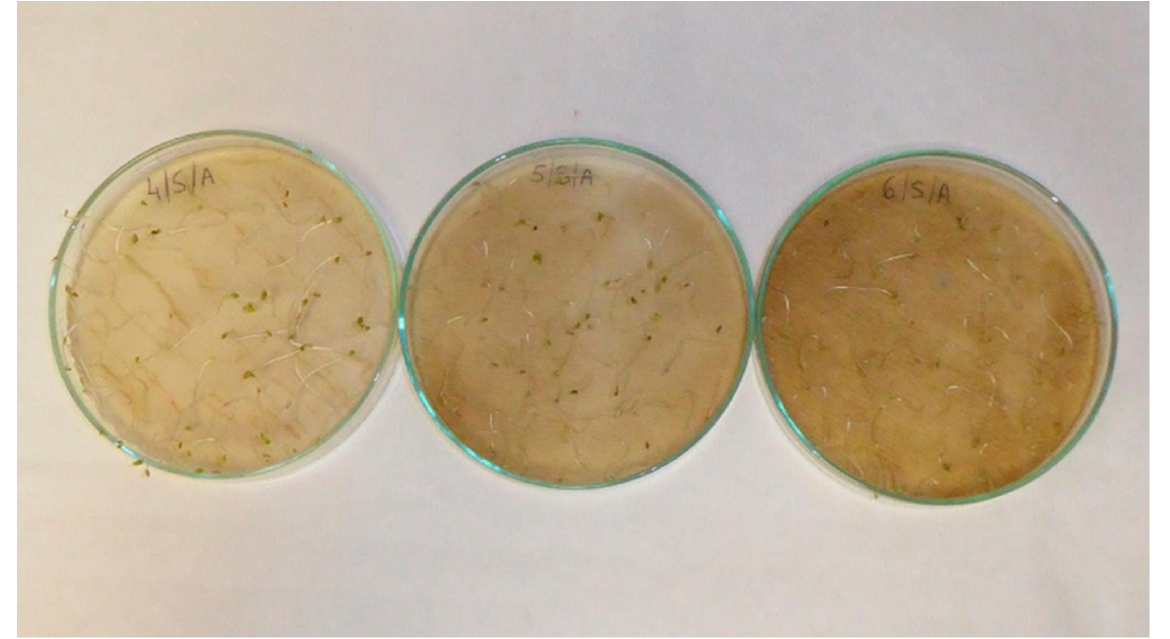
Figure A11. Lettuce ( Lactuca sativa L.) seedlings; treatments with aqueous extracts of wormwood herbs ( Artemisia absinthium L.) in 2.5% concentration ( left ) 5% concentration ( middle ) and 10% concentration ( right ).